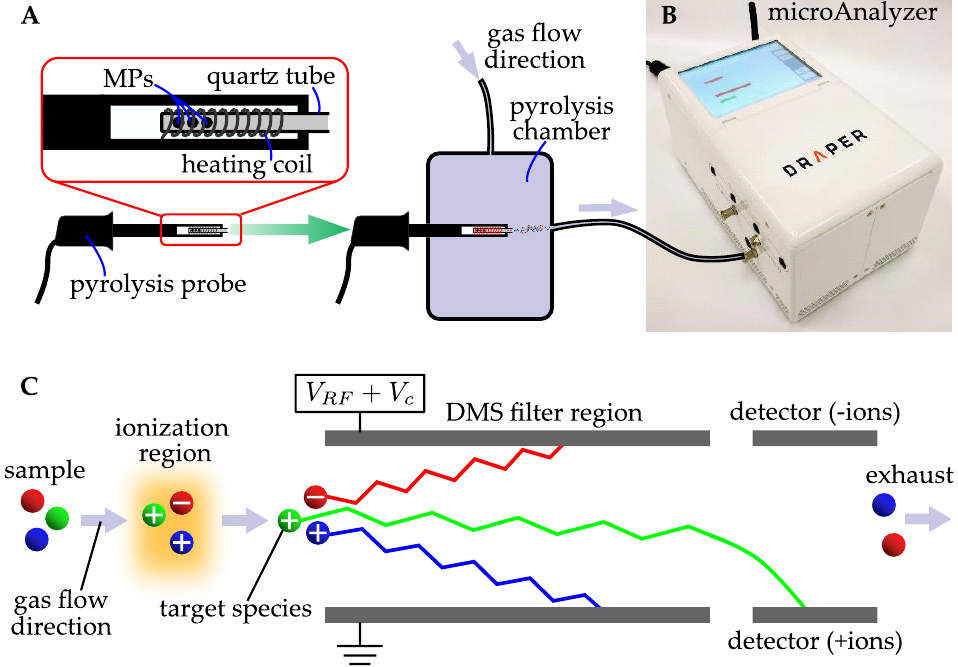
Figure 2. ( A ) General work-flow and instrumentation for the Py/GC-DMS study. The MP sample (prepared in a quartz tube) is placed into the pyrolysis probe attached to the pyrolysis chamber. The probe is inserted into the CDS 1500 interface unit. The interface unit is connected to the sampling inlet of the microAnalyzer in ( B ). ( C ) A schematic illustration of the DMS principle of operation. A radiofrequency ( V RF ) and constant electric field ( V C ) are applied across parallel plates, filtering ions based on their mobility. In this illustration, the green ion, labeled “target species”, travels without contacting the parallel plates and is detected at the positive ion detector.